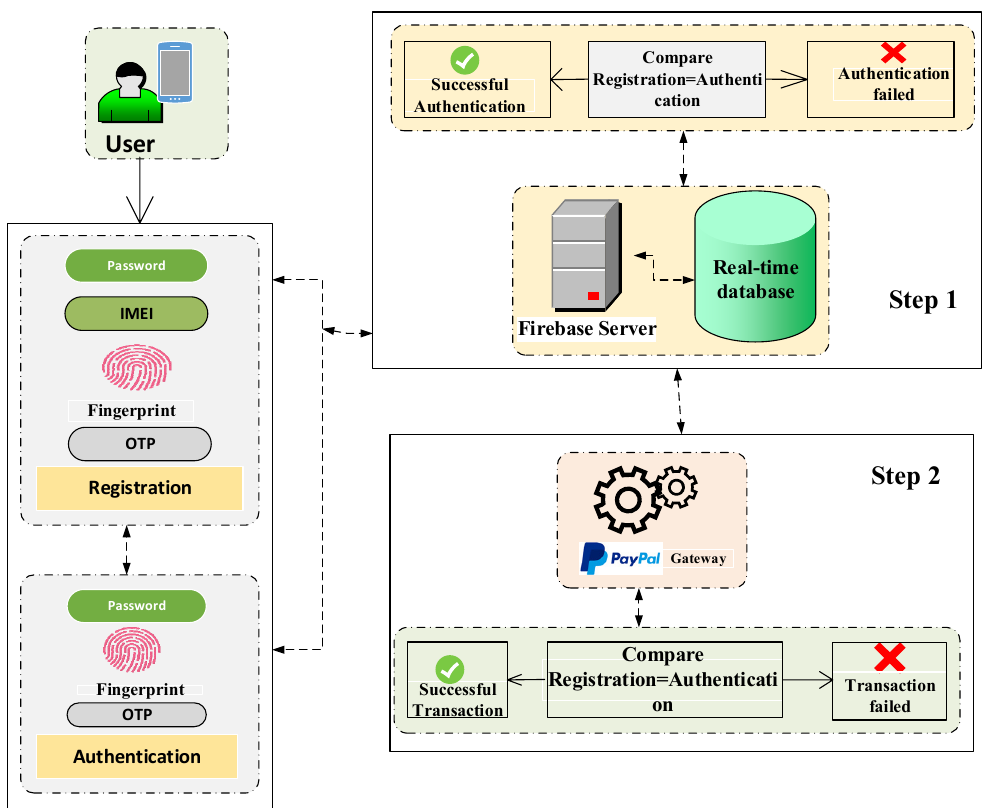
Figure 1. The framework for the proposed technique.